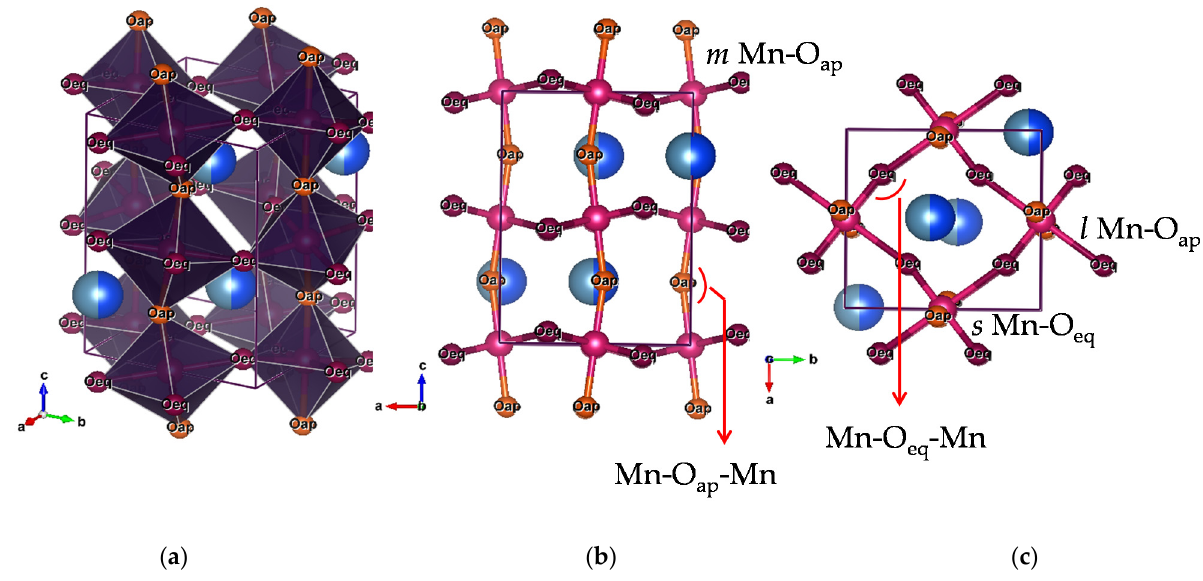
Figure 4. Room temperature orthorhombic Pbnm unit cell of Ho 0.5 Ca 0.5 MnO 3 nanoparticles. ( a ) Interconnection of MnO 3 octahedra through apical (O ap ) and equatorial (O eq ) oxygen atoms. Mn atoms are within the octahedra. The Ho/Ca sites are depicted as virtual balls composed of half Ho and half Ca of different blue shades. ( b ) Projection of the unit cell along the [010] orthorhombic direction. ( c ) Projection of the unit cell along the [001] orthorhombic direction. The mean values of the intermediate, short, and long Mn-O bond distances (respectively m Mn-O ap , s Mn-O eq , l Mn-O eq ) and of the Mn-O ap -Mn and Mn-O eq -Mn bond angles are: Mn-O eq -Mn = 151.4 ◦ , Mn-O ap -Mn = 158. 1 ◦ ; m Mn-O ap = 1.91 Å, s Mn-O eq = 1.87 Å, l Mn-O eq = 2.05